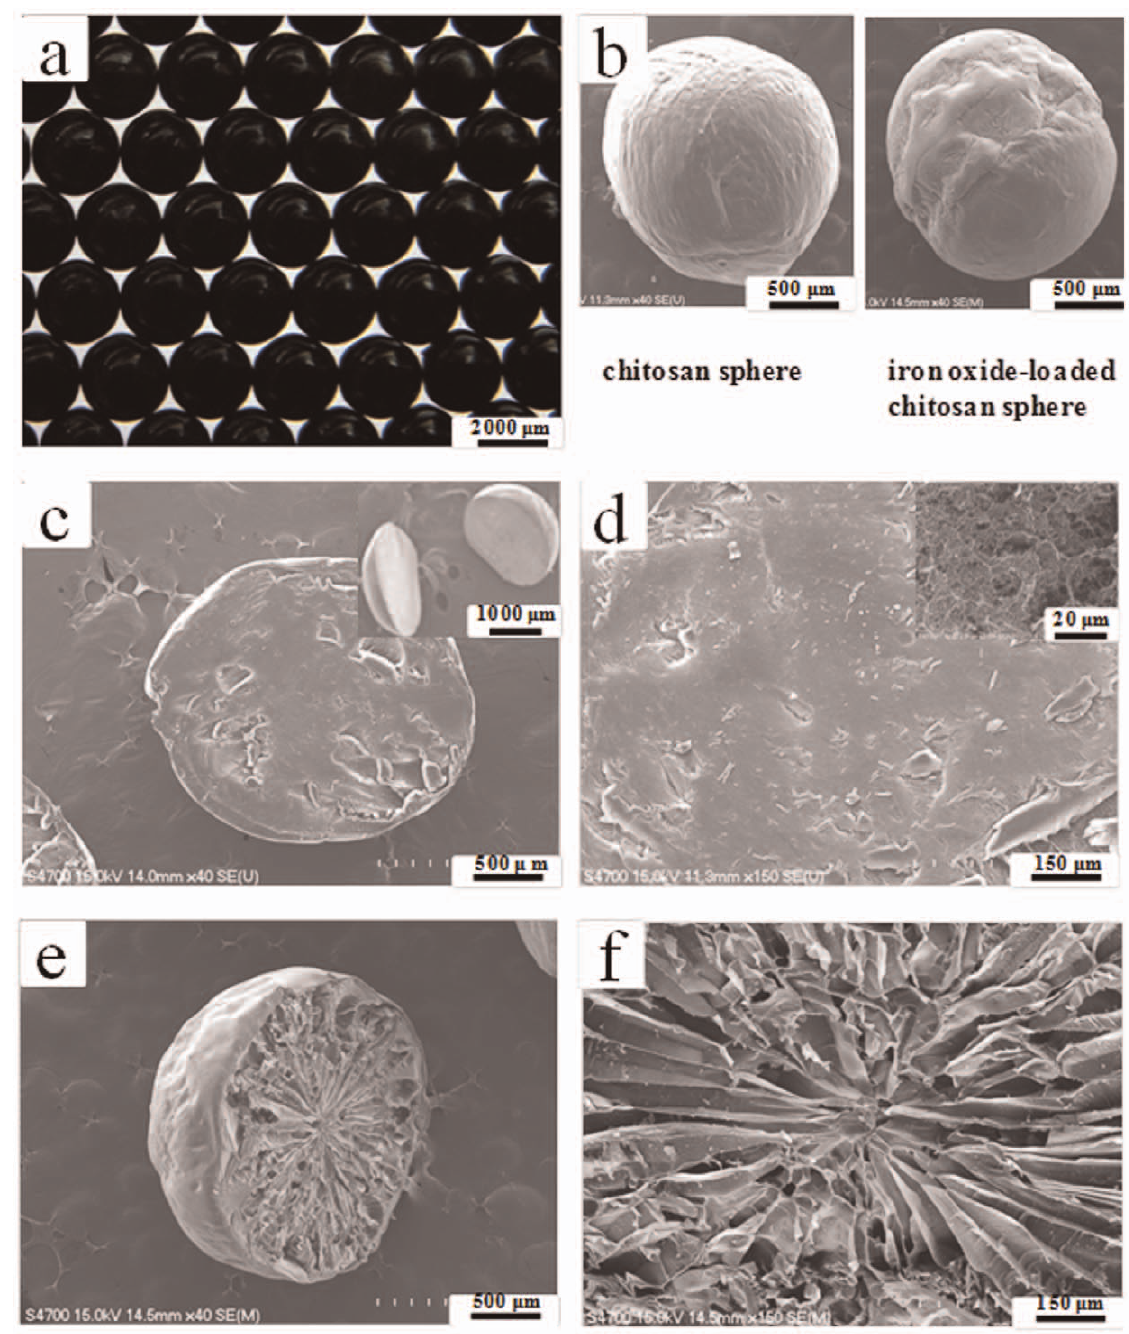
Figure 2. Morphologies of the synthesyzed chitosan spheres. (a) An optical image of the iron oxide nanoparticles loaded chitosan spheres. (b) SEM images of chitosan spheres without (left) and with (right) iron oxide nanoparticles. (c) and (d) show the cross-section images of chitosan spheres (without iron oxide nanoparticles). Inset in (c) shows the sliced hemispheres of chitosan sphere. Inset in (d) shows details of the internal structure. (e) and (f) show the cross-section images of iron oxide nanoparticles loaded chitosan spheres.